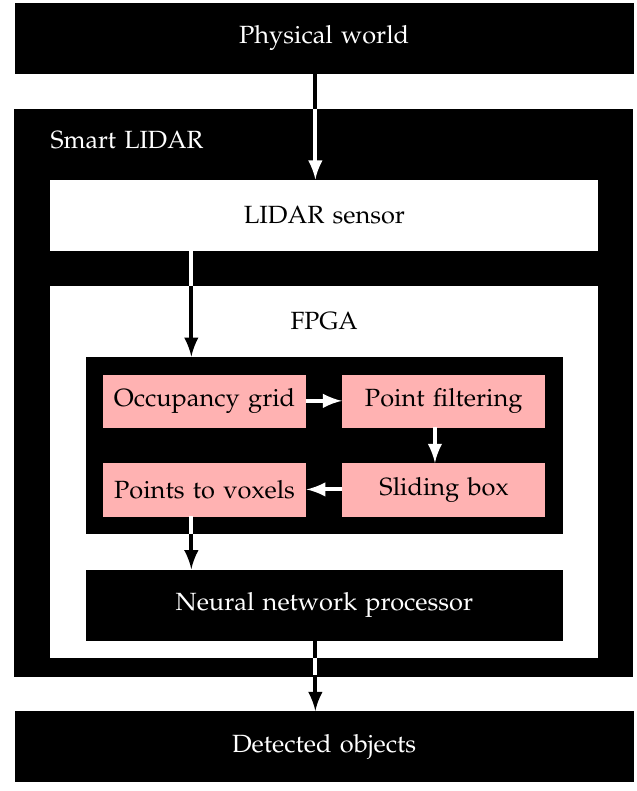
Figure 8. Smart LIDAR for the object classification case study.